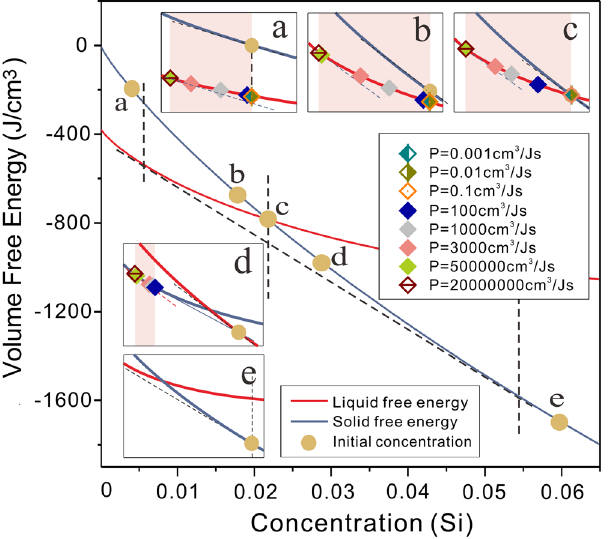
Figure 4. Evaluated nucleus compositions for different Al-Si alloys according to different interfacial